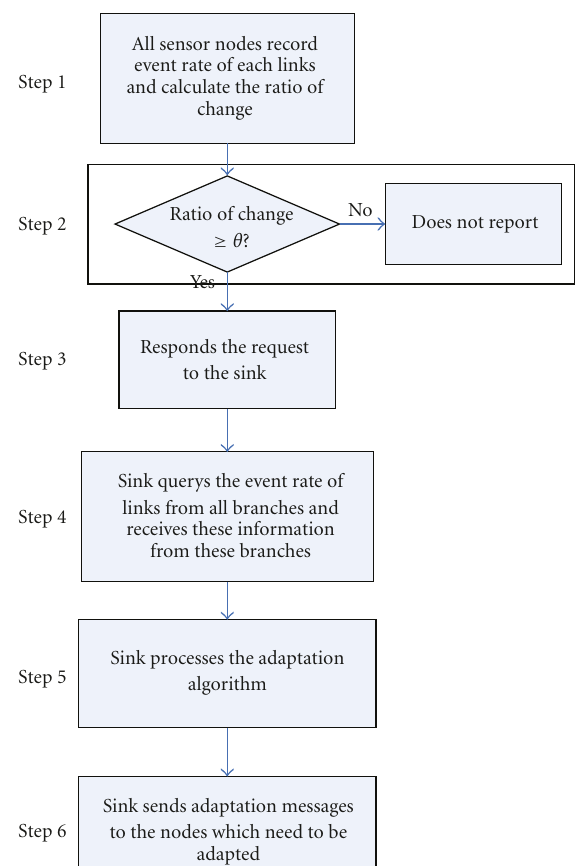
Figure 4: Flow chart of MTA procedure on